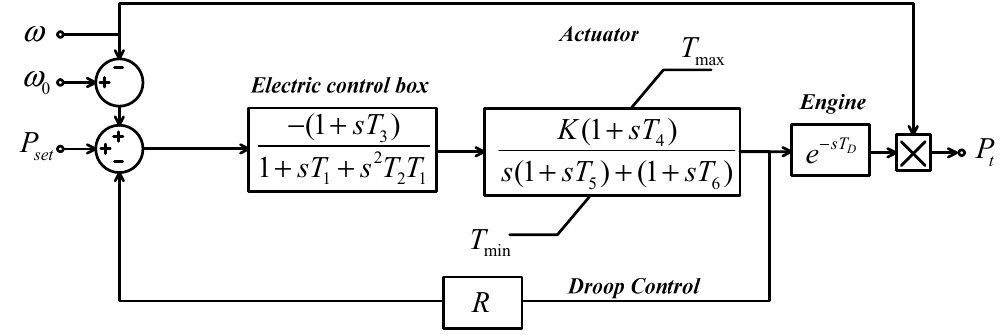
Figure 5. DEGOV1 diesel governor model.